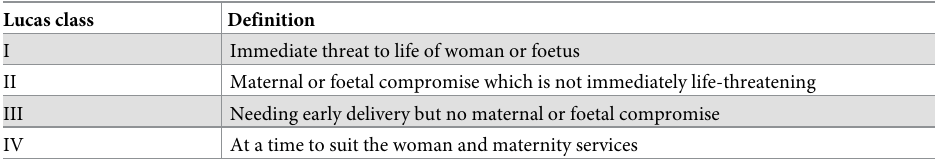
Table 4. Lucas classification of urgency of CD.